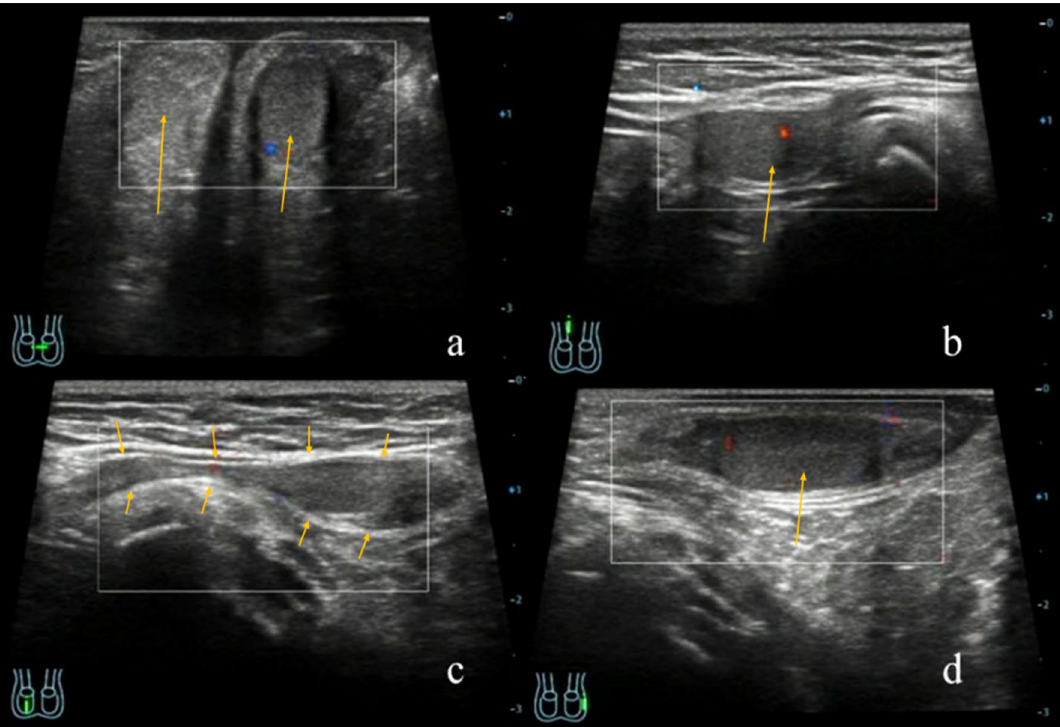
Figure 2. Ultrasound features of EAT on the right side of a 10-months-old boy. (a) The cross section of the scrotum has showed that the left testicular was in the left scrotum, and the right testicular echo was not in the right scrotum (b) and the upper part of the right inguinal canal near the inner ring showed the right testicular, and CDFI showed punctate blood flow signals inside (c) and the right testis can be moved down to the middle part of the right inguinal canal (d) and the CDFI of the left testis longitudinal section showed punctate blood flow signal in the left testis (arrows).